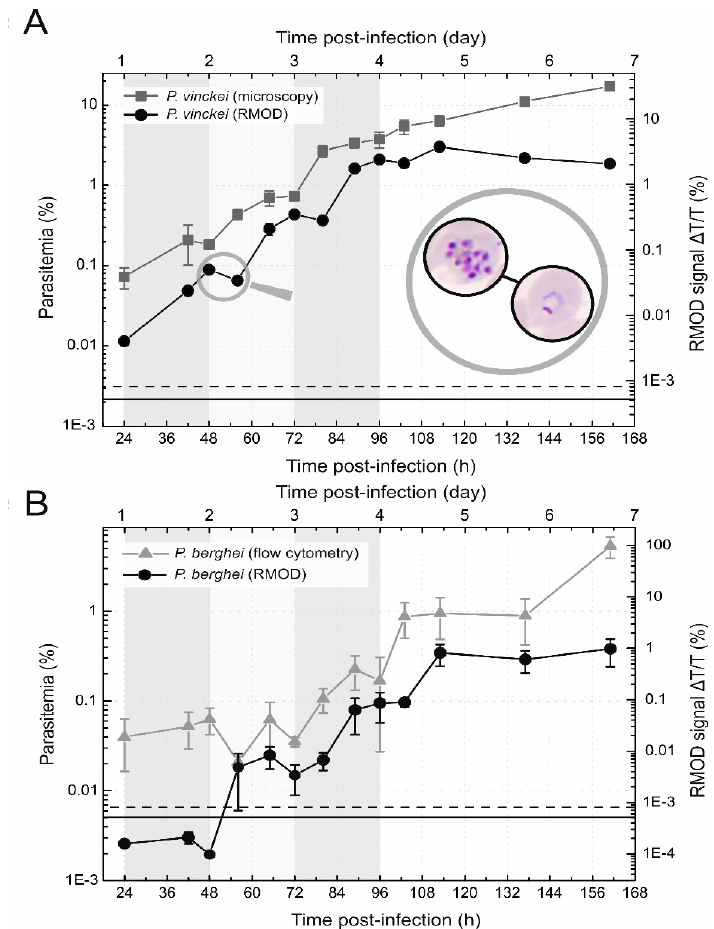
Figure 4. Detection of cyclic development of intra-erythrocytic P. vinckei and P. berghei infection. ( A ) The cyclic development of the P. vinckei infection. The black circles represent the RMOD signal, while the gray squares represent the parasitemia values determined by microscopy. Each symbol and error bar represents the average and standard deviation of values measured on blood samples from n = 5 mice. The magnifying glass shows the pictures taken during the examination of smears at 48 h and at 56 h post-infection, displaying the parasitic stage most representative of the given smear; i.e. schizonts and rings, respectively. ( B ) The cyclic development of P. berghei parasites at the beginning of the blood stage infection. The black circles represent the RMOD signal, while the gray triangles represent the parasitemia values determined by flow cytometry. Each symbol and error bar represents the average and standard deviation of values measured on blood samples from n = 4 mice. The background shading indicates the assessed layout of the first three 24-hour erythrocytic cycles. The continuous black line represents the average of the RMOD values of ~20 uninfected control samples. The dashed black lines indicate the detection limit defined as the average plus two times the standard deviation of the uninfected values.